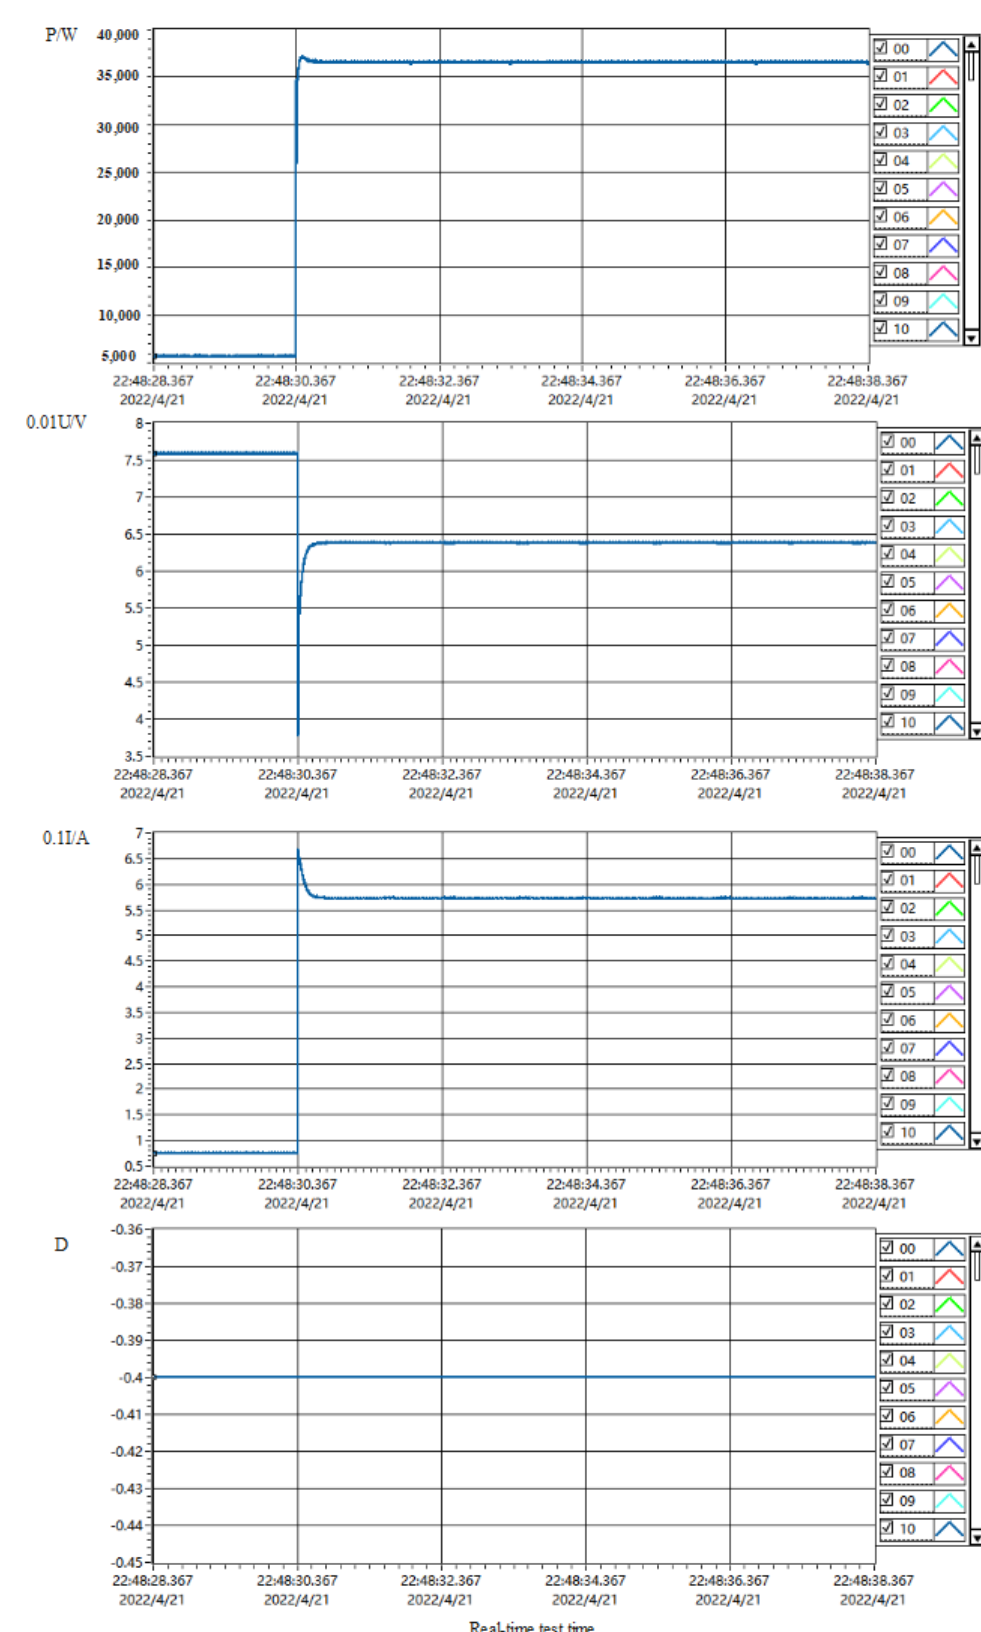
Figure 17. TSO output curves based on real-time simulation platform.